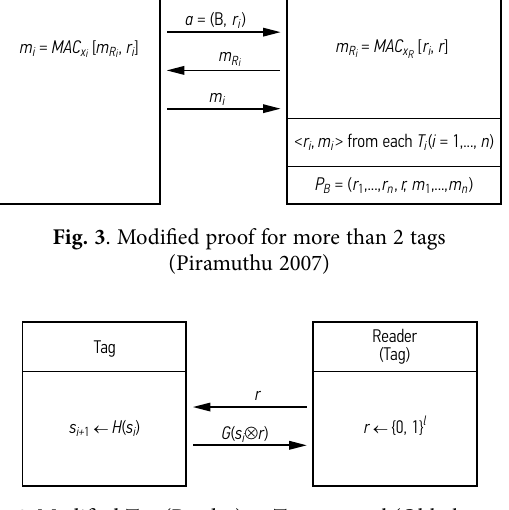
Fig. 4 . Modified Tag (Reader) to Tag protocol (Ohkubo et al. 2003; Avoine et al. 2005); Piramuthu (2007) and